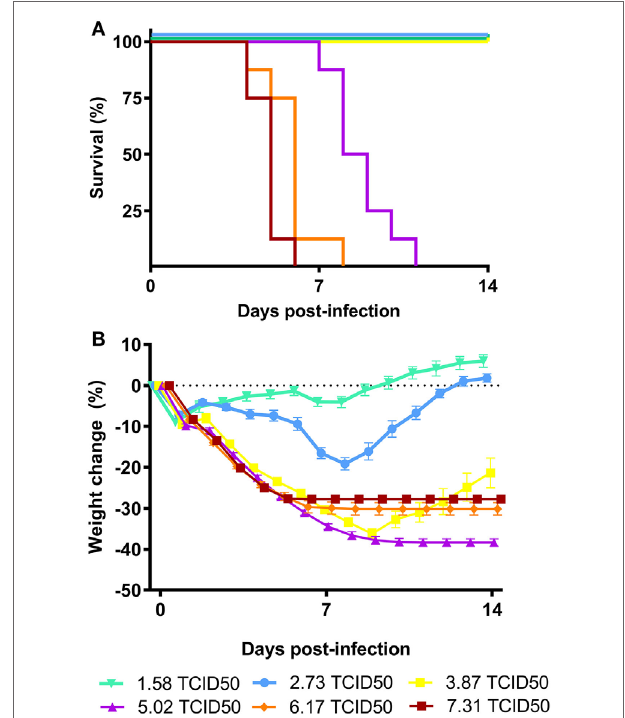
FigUre 1 | Virulence of influenza A/Anhui/1/2013 (H7N9) in BALB/c mice. Female BALB/c mice ( n = 8 per group) were intranasally inoculated with serial dilutions of the A/Anhui/1/2013 (H7N9) influenza virus on day 0 and survival was monitored for 14 days. Kaplan–Meyer survival curve (a) and mean body weight change is depicted (B) . The MLD 50 was calculated using the Reed–Muench